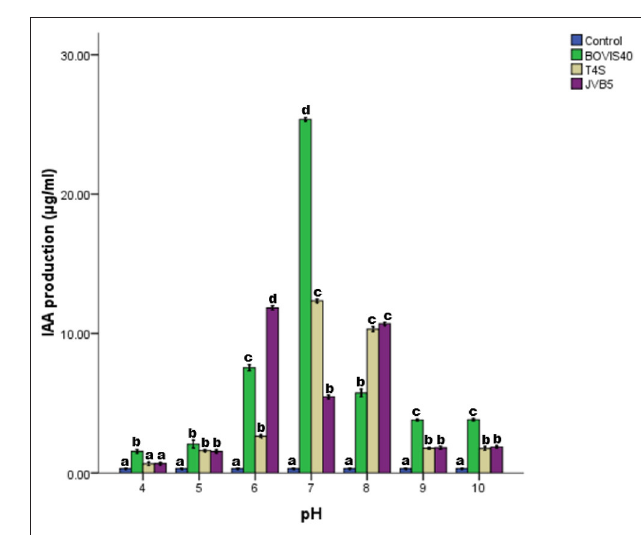
FIGURE 5 | IAA production by endophytic bacteria in the growth medium after 11 days of incubation. The different alphabets indicate significant differences in triplicate readings.